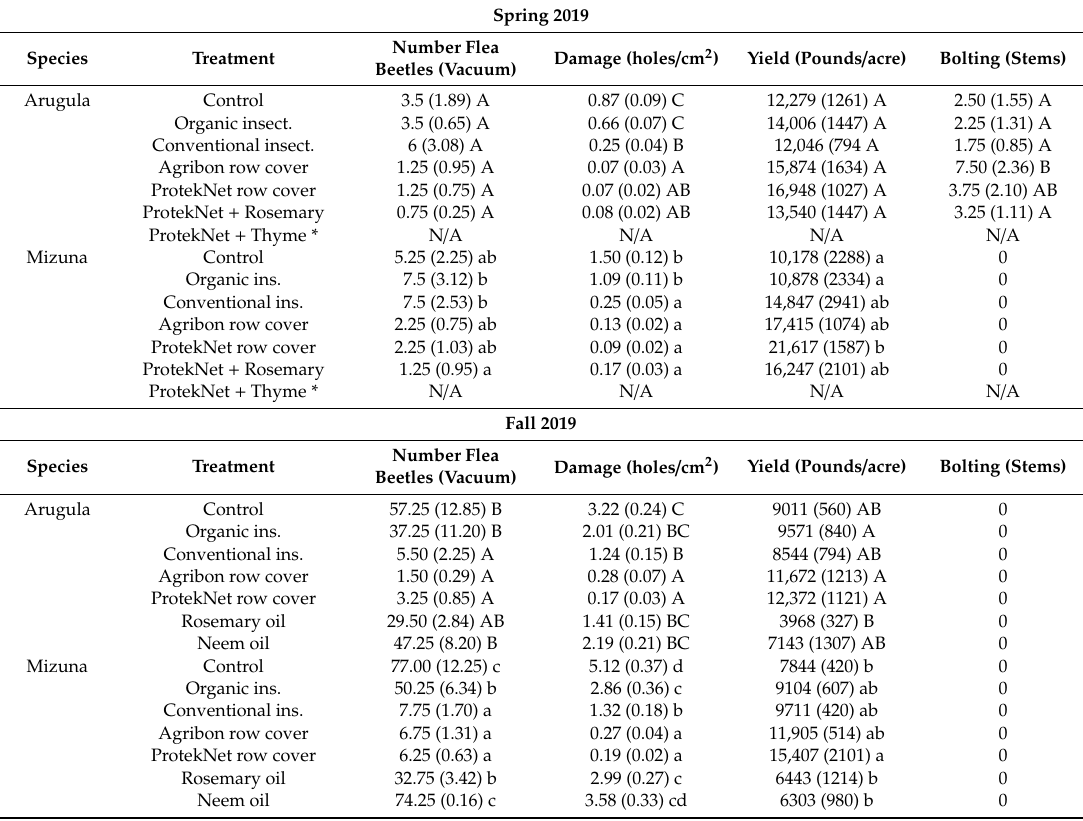
Table 3. E ff ects of treatment on number of flea beetles caught by vacuum (mean and standard error), flea beetle damage per unit leaf area (mean and standard error), yield in pounds per acre (mean and standard error), and the number of stems bolting (mean and standard